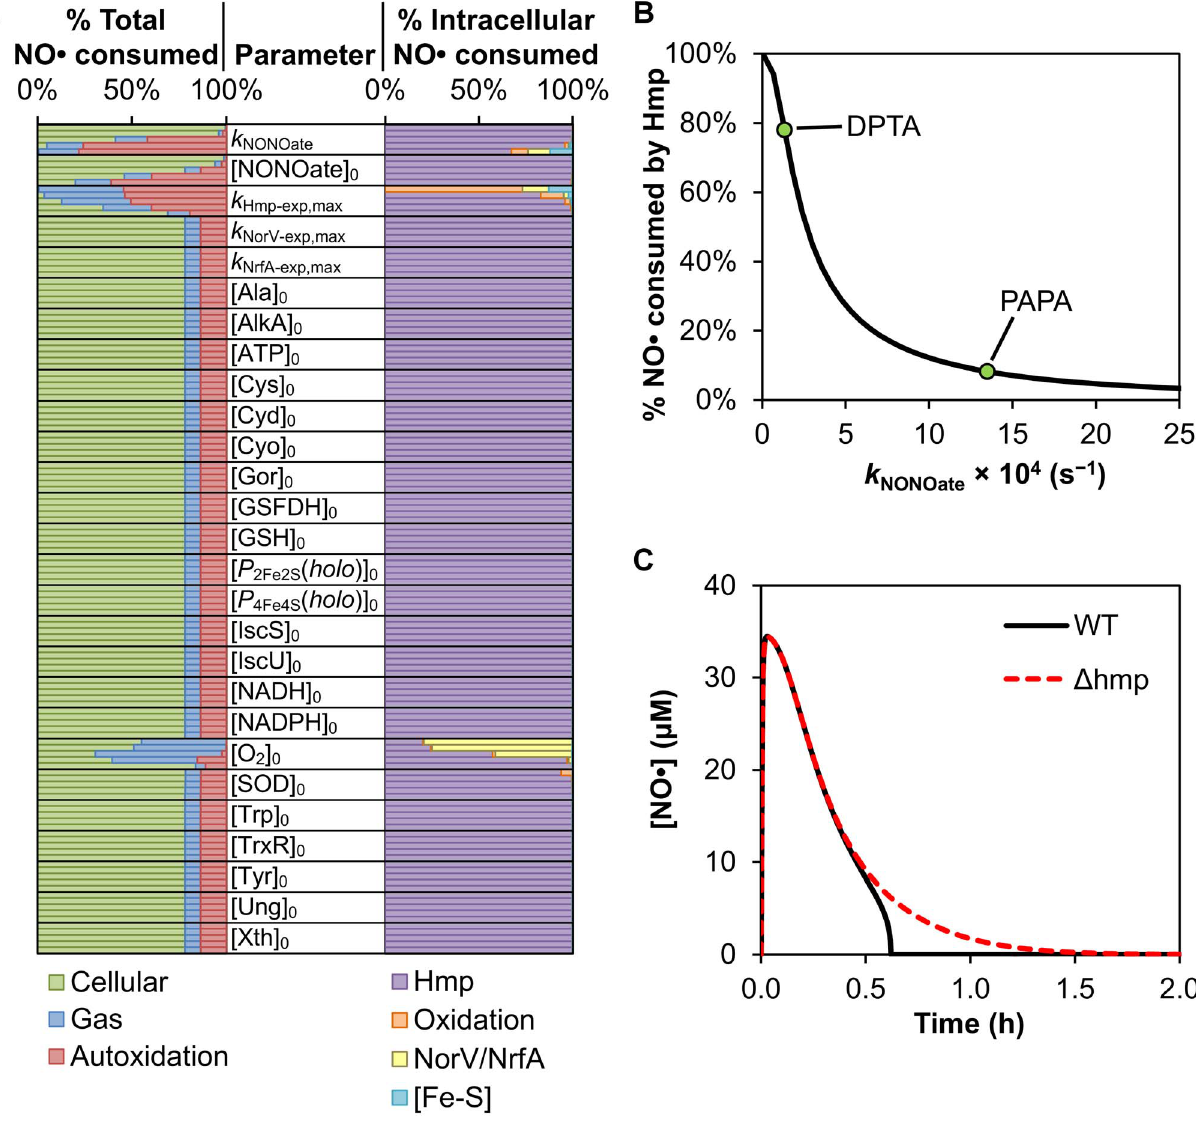
Figure 4. Effect of experimentally-accessible parameters on NO N dynamics. (A) Predicted total (left column) and intracellular (right column) NO N distributions corresponding to variation in 27 experimentally-accessible parameters. Each parameter name is listed adjacent to the 5 total and intracellular NO N distributions obtained as a result of varying that parameter logarithmically within its physiological range. The distributions are ordered such that the parameter is increasing in value from top to bottom. (B) Percentage of total NO N predicted to be consumed by Hmp as a function of NO N donor release rate. Points (green circles) correspond to the release rates measured for DPTA and PAPA. (C) Simulated NO N concentration profile for wild-type (solid black line) and D hmp (red dashed line) cultures treated with 0.5 mM PAPA.